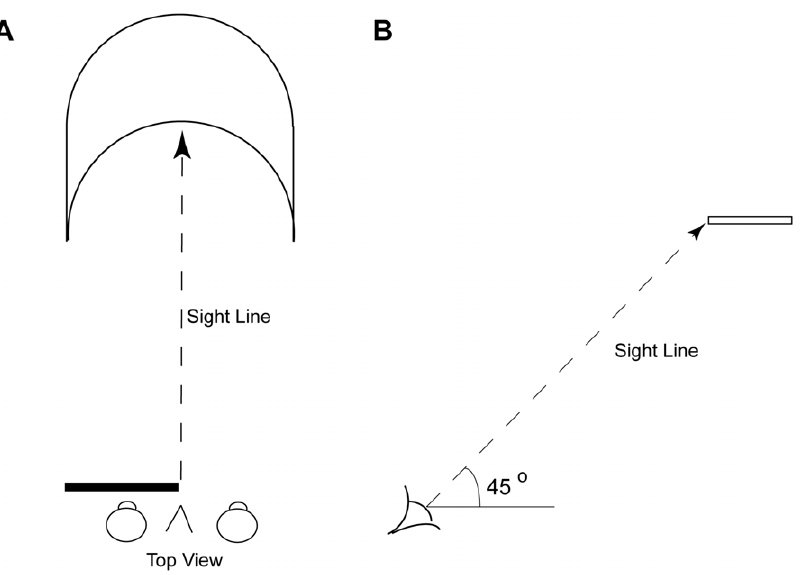
Figure 6. Visuo-haptic interactions with a real object. Griffiths & Zaidi [7] showed that a real flat object with curved edges appears curled in monocular viewing, but the percept can be corrected locally while touching the front edge. To view the illusion, with one eye covered, the shape (A) is held directly in front of the observer, with the straight edges parallel to the line of sight. The shape is then slowly raised until the line of sight is elevated from the horizontal by approximately 45 u . The physically flat object then appears to be curled upwards. If the observer holds the object at the tips of the curved edge with both hands, the strength of the illusory percept is reduced, showing that haptic depth information interacts with visual cues. In addition, it is possible to break the illusion by running a finger along the closest edge of the object. If an observer touches one end of the closer curved edge, it is still possible to see the opposite end of the stimulus as having an illusory curl. If the observer then slowly runs a finger along the closer curved edge, the illusion gradually disappears around the region closest to the finger, but returns in the wake of the finger’s passage. The effect of the haptic feedback in diminishing the illusory percept is thus local and temporary.